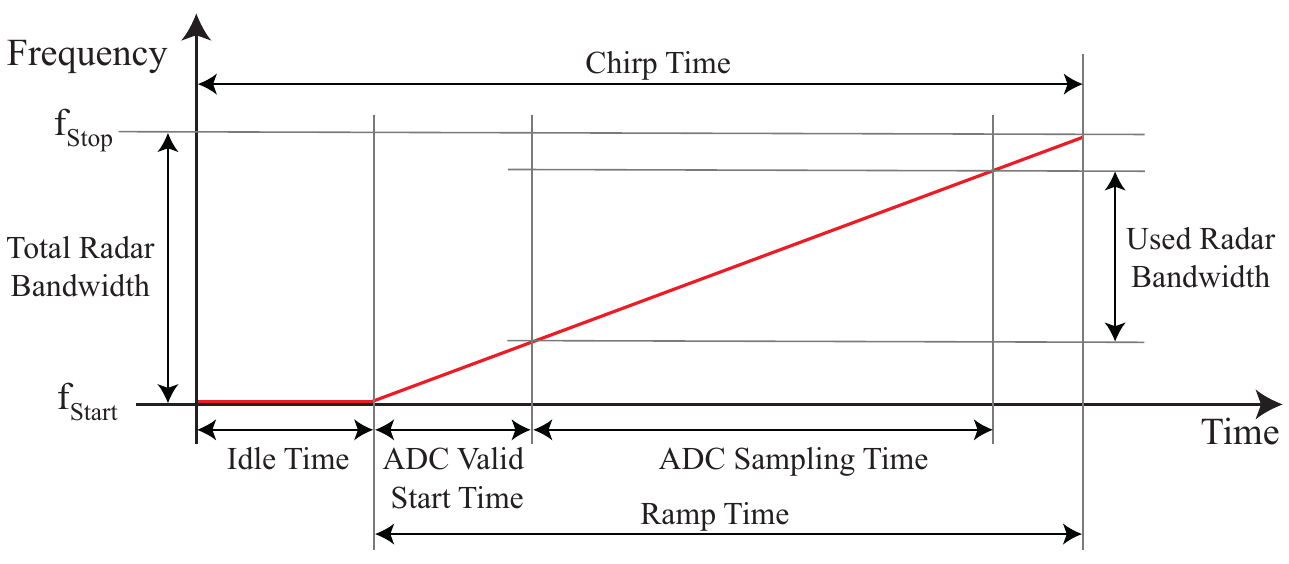
Figure 5. Chirp time graphical representation. Frames are used to organize chirps transmission. Each frame can contain at least 1 chirp up to a maximum of 255 ones. Figure 6 shows how chirps are transmitted in